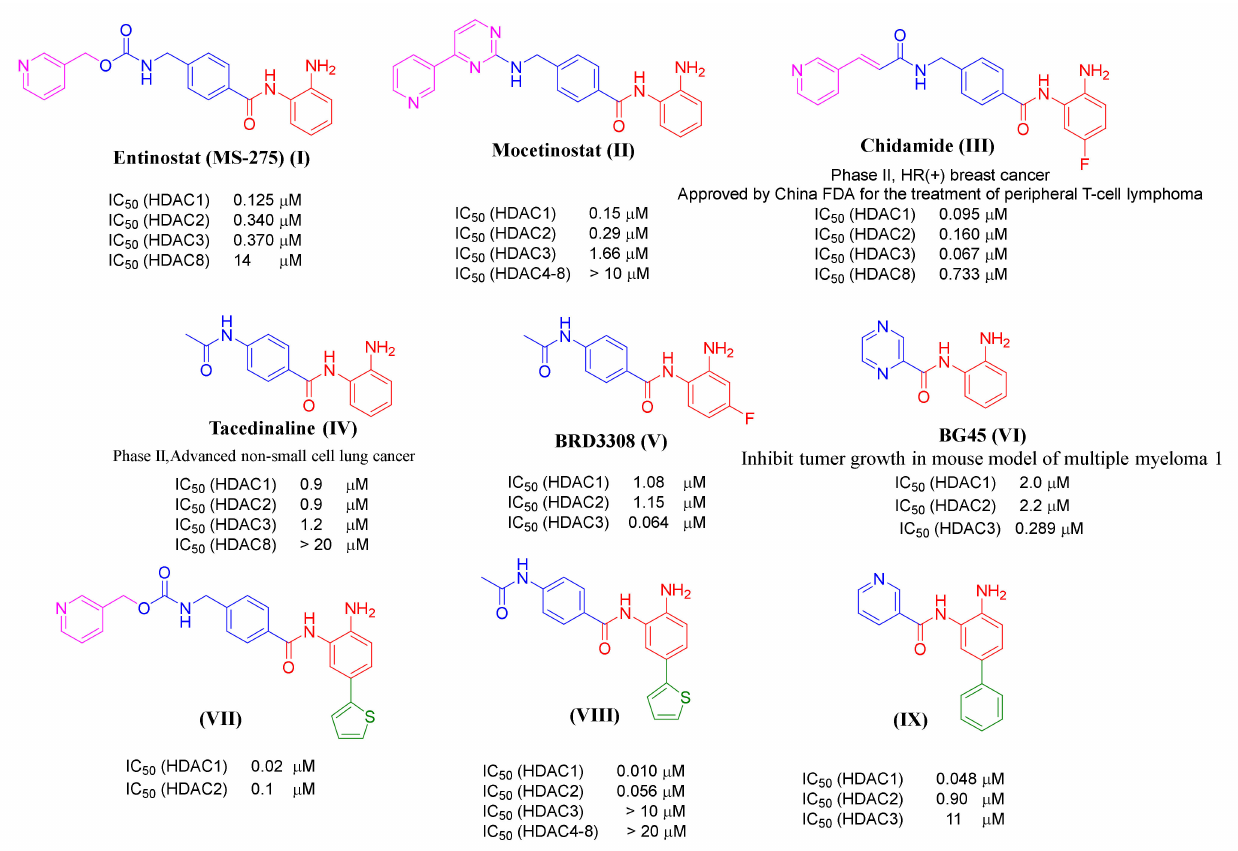
Figure 1. Examples of previously reported 2-aminobenzamides and their inhibitory activity towards different HDAC subtypes. The different pharmacophoric groups of the inhibitors are marked in color (ZBG in red, substitutions interacting with the HDAC1/HDAC2 foot pocket in green, linker colored in blue, capping group colored in